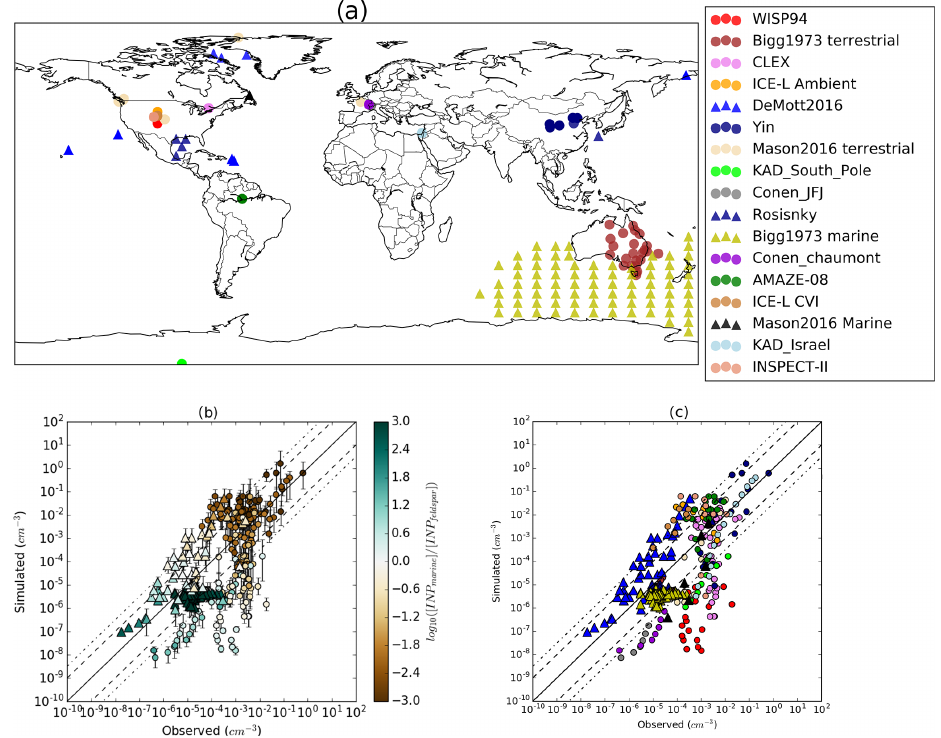
Figure 9. (a) Location of the data used for comparison in Fig. 8. (b) Same as Fig. 8d but showing the relative contribution (in orders of magnitude) of each aerosol species to the simulated concentration. (c) Same as (b) but distinguishes between the different campaigns shown in (a) (with the same colours and symbols). References to the data sets used are shown in Appendix